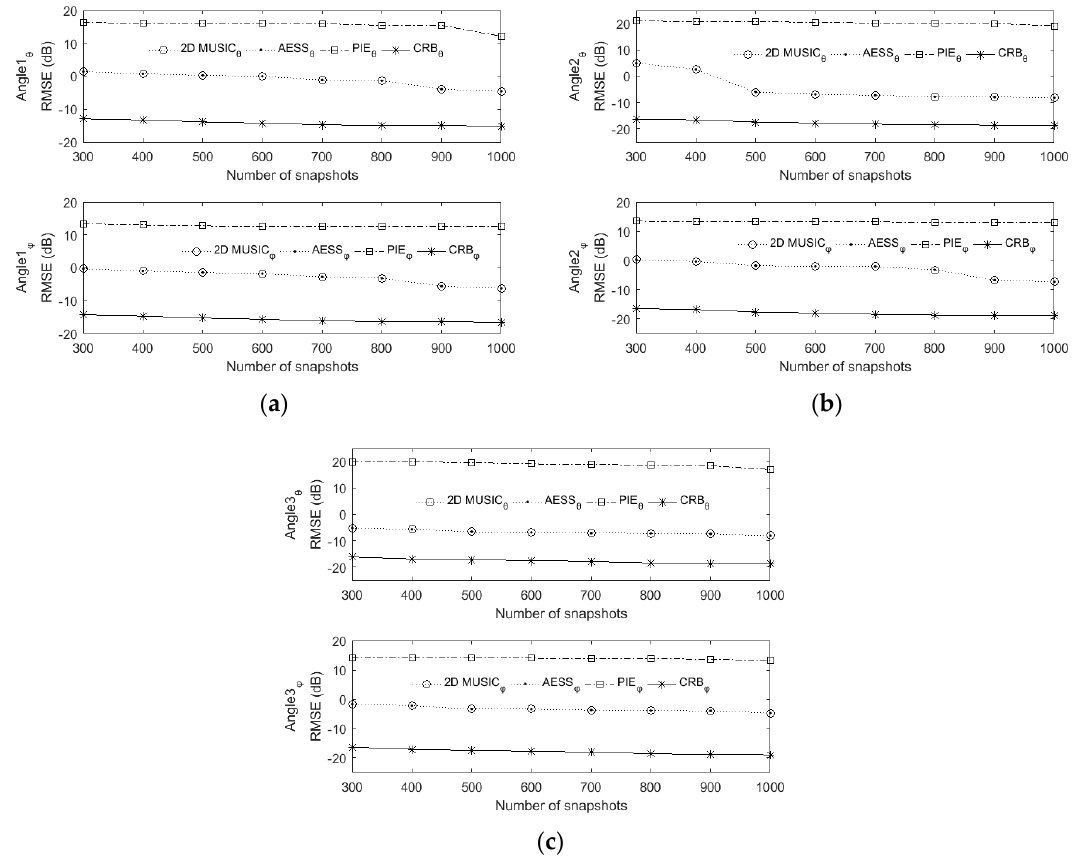
Figure 8. RMSE versus snapshot. SNR is set to be 0 dB, stepsize is set to be 0.1 ◦ . ( a ) The first source come from ( 20 ◦ ,40 ◦ ) ; ( b ) The second source come from ( 75 ◦ ,50 ◦ ) ; ( c ) The third source come from ( 35 ◦ ,60 ◦ )